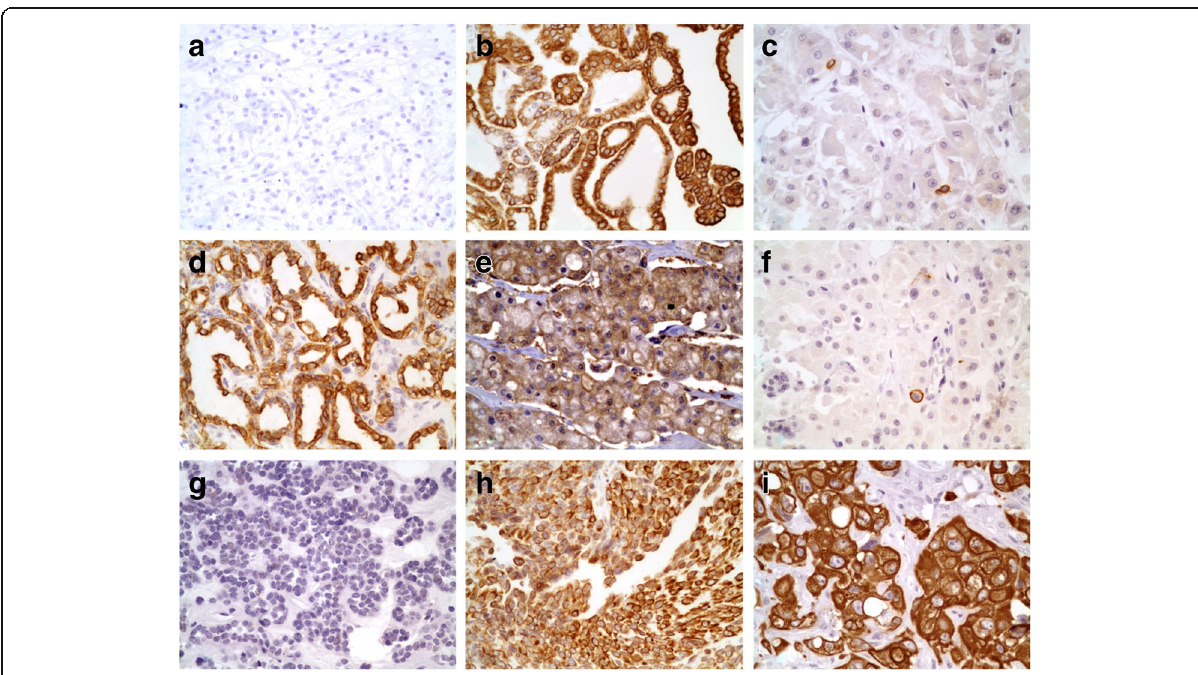
Fig. 2 TGR5 staining - a Clear cell RCC: negative for TGR5 (400X). b Type 1 papillary RCC: strongly positive for TGR5 (400X). c Type 2 papillary RCC: weakly positive with focal cells expressing TGR5 (400X). d Clear cell papillary RCC: strongly positive for TGR5 (400X). e Chromophobe RCC: moderate expression of TGR5 (400X). f Oncocytoma: weakly positive with focal cells expressing TGR5 (400X). g Metanephric adenoma: negative for TGR5 (400X). h Urothelial carcinoma of the renal pelvis: strongly positive for TGR5 (400X). i Poorly differentiated urothelial carcinoma with sarcomatoid features: strongly positive for TGR5